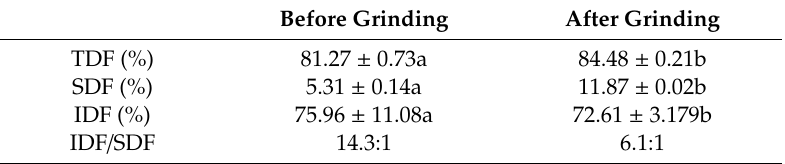
Table 2. E ff ects of ultra-micro grinding on the content of dietary fiber. a. Before Grinding After Grinding